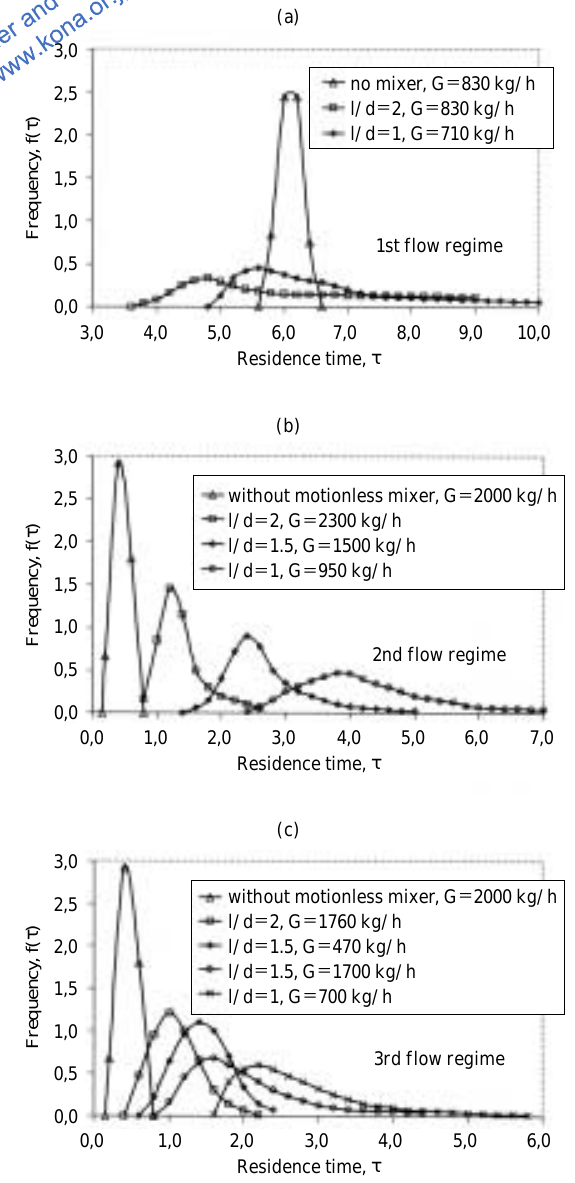
Fig. 7 Residence time distribution curves obtained with Kenics- type motionless mixers in different flow regimes ( a ) 1 st flow regime, ( b ) 2 nd flow regime, ( c ) 3 rd flow